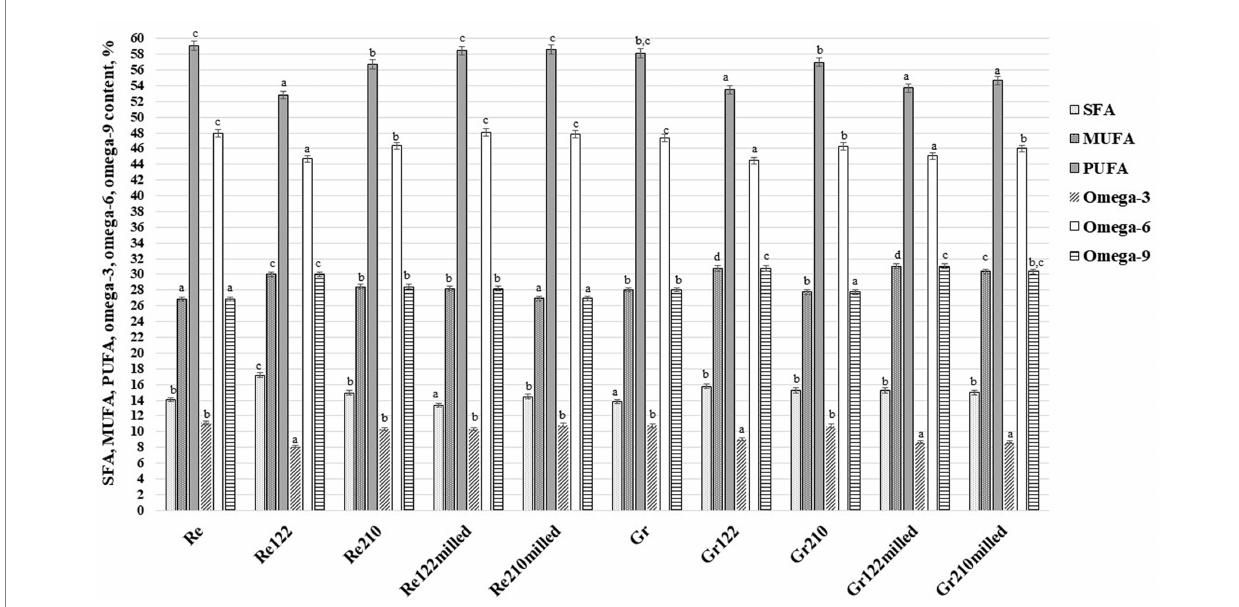
FIGURE 3 Saturated (SFA), monounsaturated (MUFA) and polyunsaturated (PUFA) fatty acid, omega-3, omega-6 and omega-9 contents in lentil samples (Re— non-treated red lentils; Gr—non-treated green lentils; 122 —fermented with Lactiplantibacillus plantarum strain; 210 —fermented with Lacticaseibacillus casei strain; milled —milled lentils; a–d Means with different letters between the columns are significantly different, when p ≤